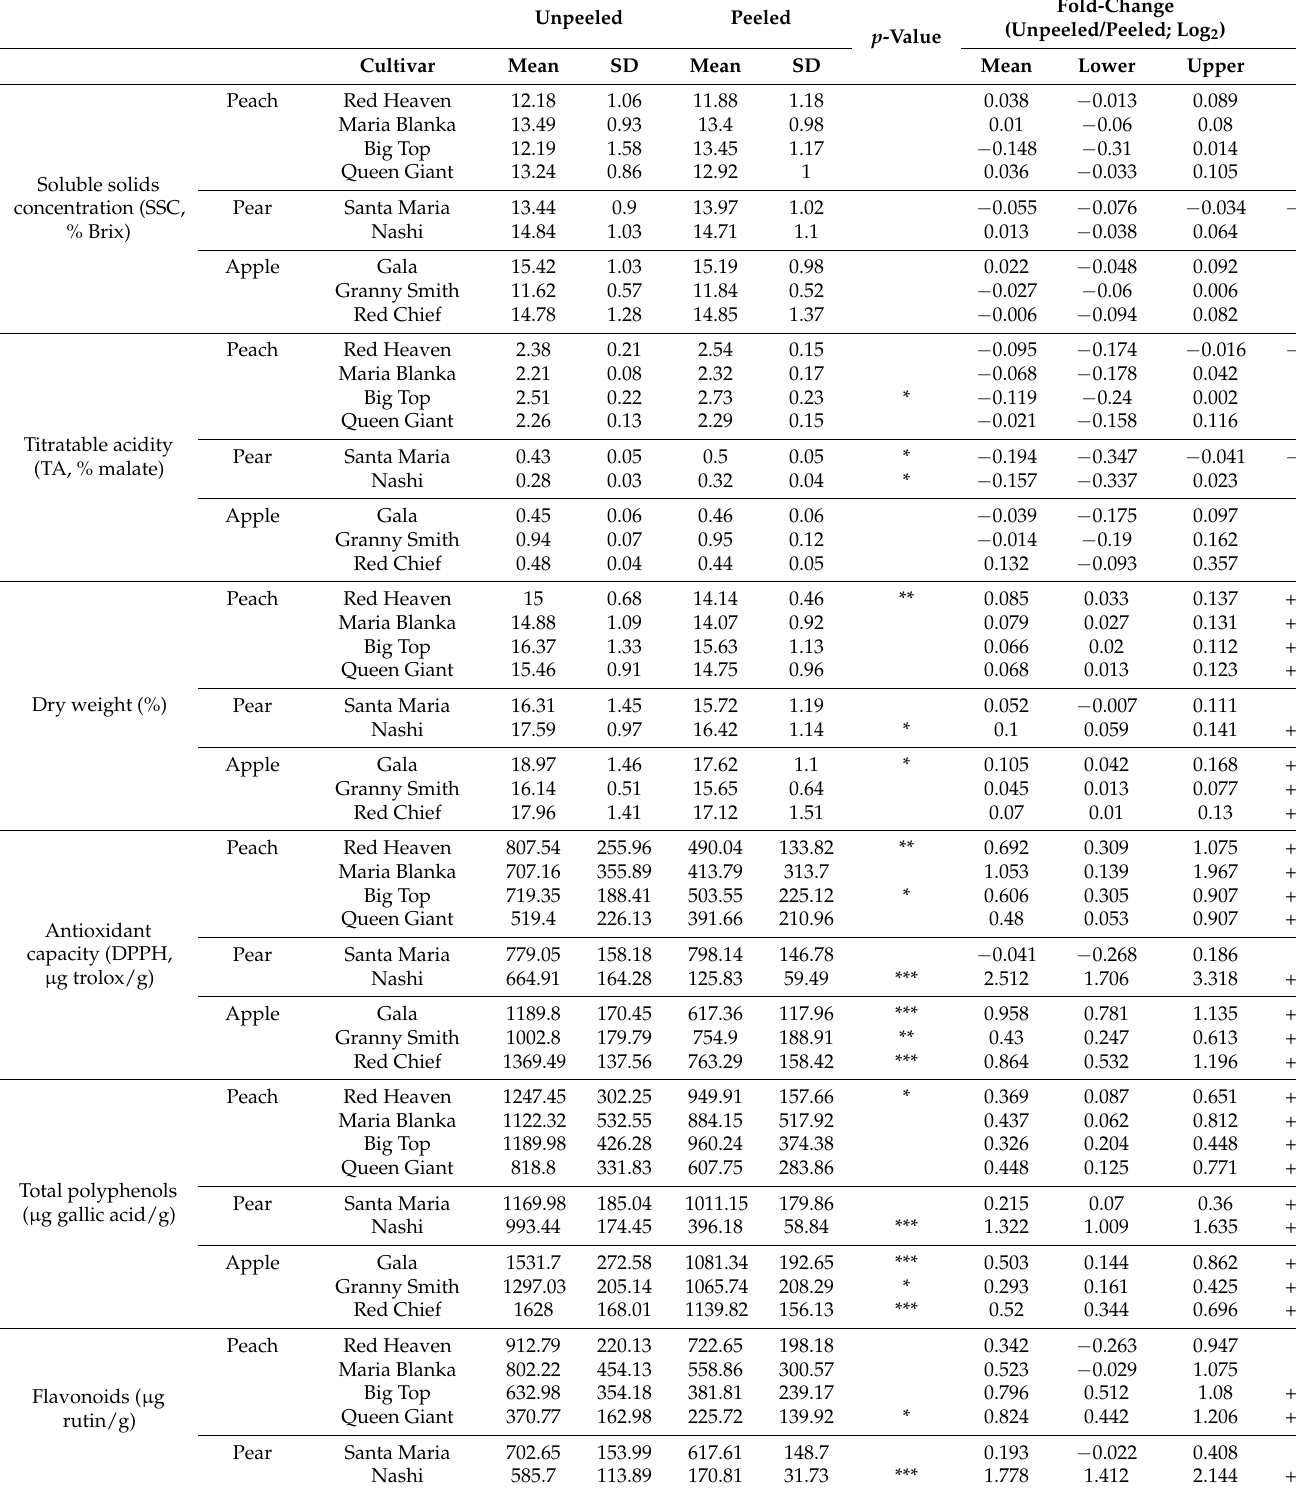
Table 1. Physio-biochemical properties of unpeeled and peeled fruit. Unpeeled Peeled